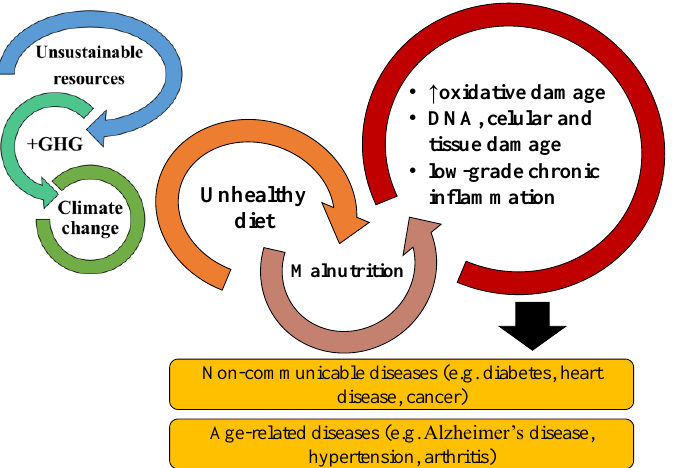
Figure 1. The relationship and risk of noncommunicable diseases and age-associated diseases are increased by malnutrition originating from poor and unhealthy diets. Malnutrition promotes increased oxidative stress, DNA, cellular and tissue damage, and chronic inflammation. Chronic inflammation is associated with most NCDs and AADs. Bad diets are also associated with the unsustainable exploitation of resources, greenhouse gases (GHG) emissions, and impacts on climate change.